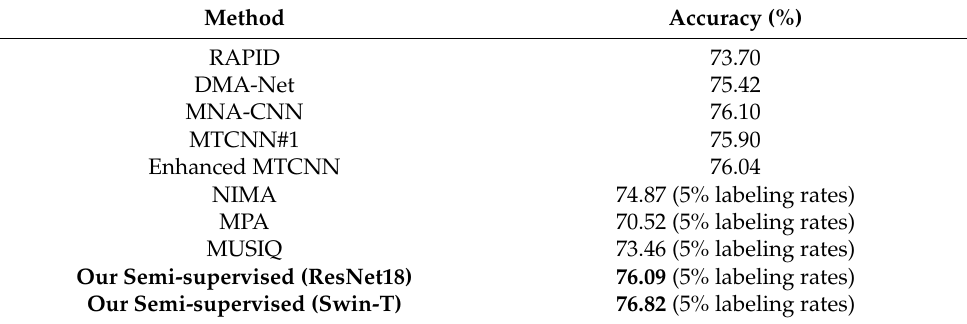
Table 5. Comparison with state-of-the-art methods on AVA